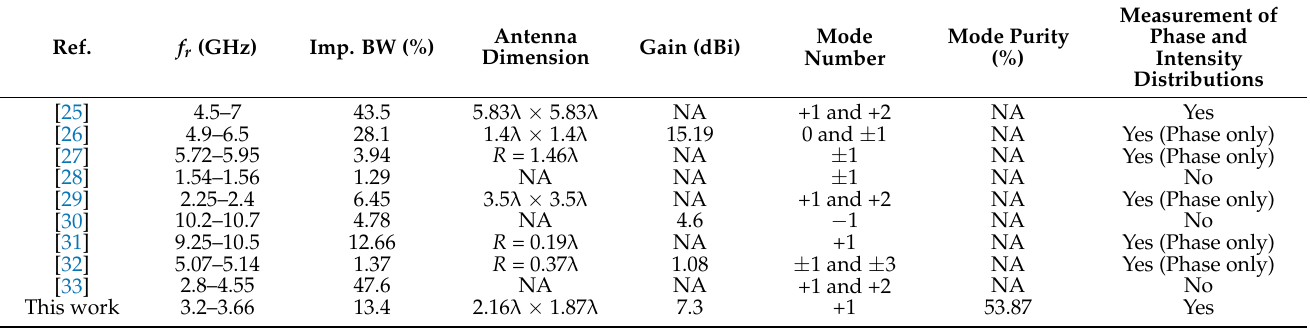
Table 2. Comparison between various OAM antennas.